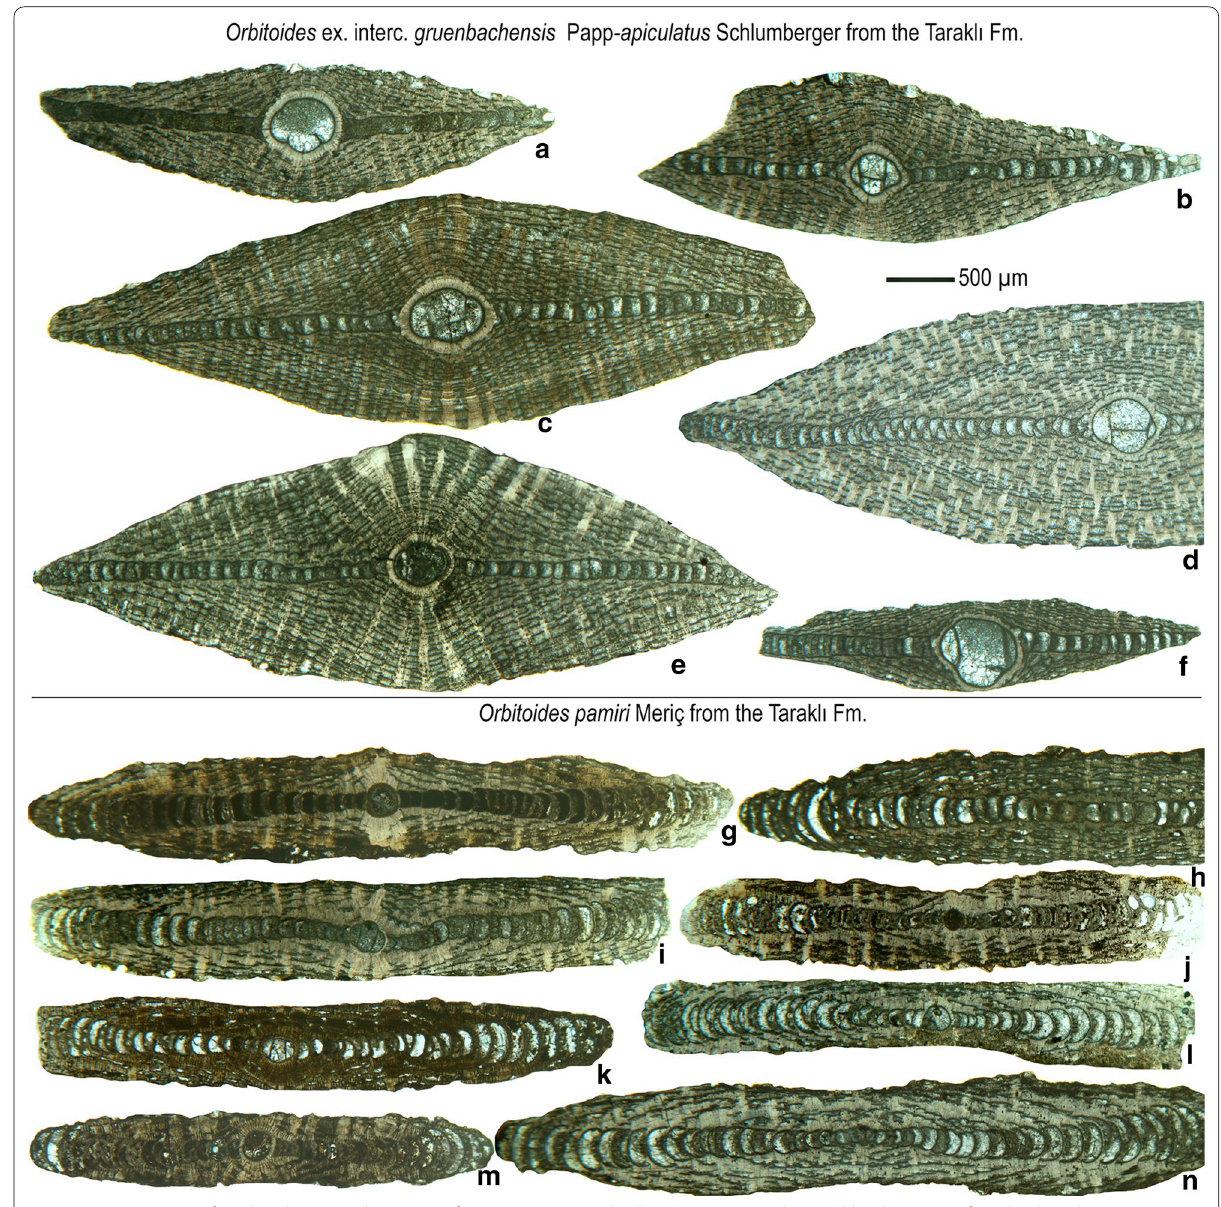
Fig. 12 Comparison of axial and near axial sections of O. ex. interc. gruenbachensis Papp– apiculatus Schlumberger ( a – f ) and Orbitoides pamiri Meriç ( g – n ) from the Taraklı Formation in Epçeler. Note the biconvex tests with numerous cycles of lateral chamberlets in the former and flat to biconcave tests with fewer cycles of lateral chamberlets in the latter species. a EPA14-33. b EPA15-22. c EPA15-24. d EPA16. e EPA16-10. f EPA14-32. g EPB5-31. h EPB6-45. i EPB5-16, j EPB5-20. k EPB5-1. l EPB5-4. m EPB5-37. n